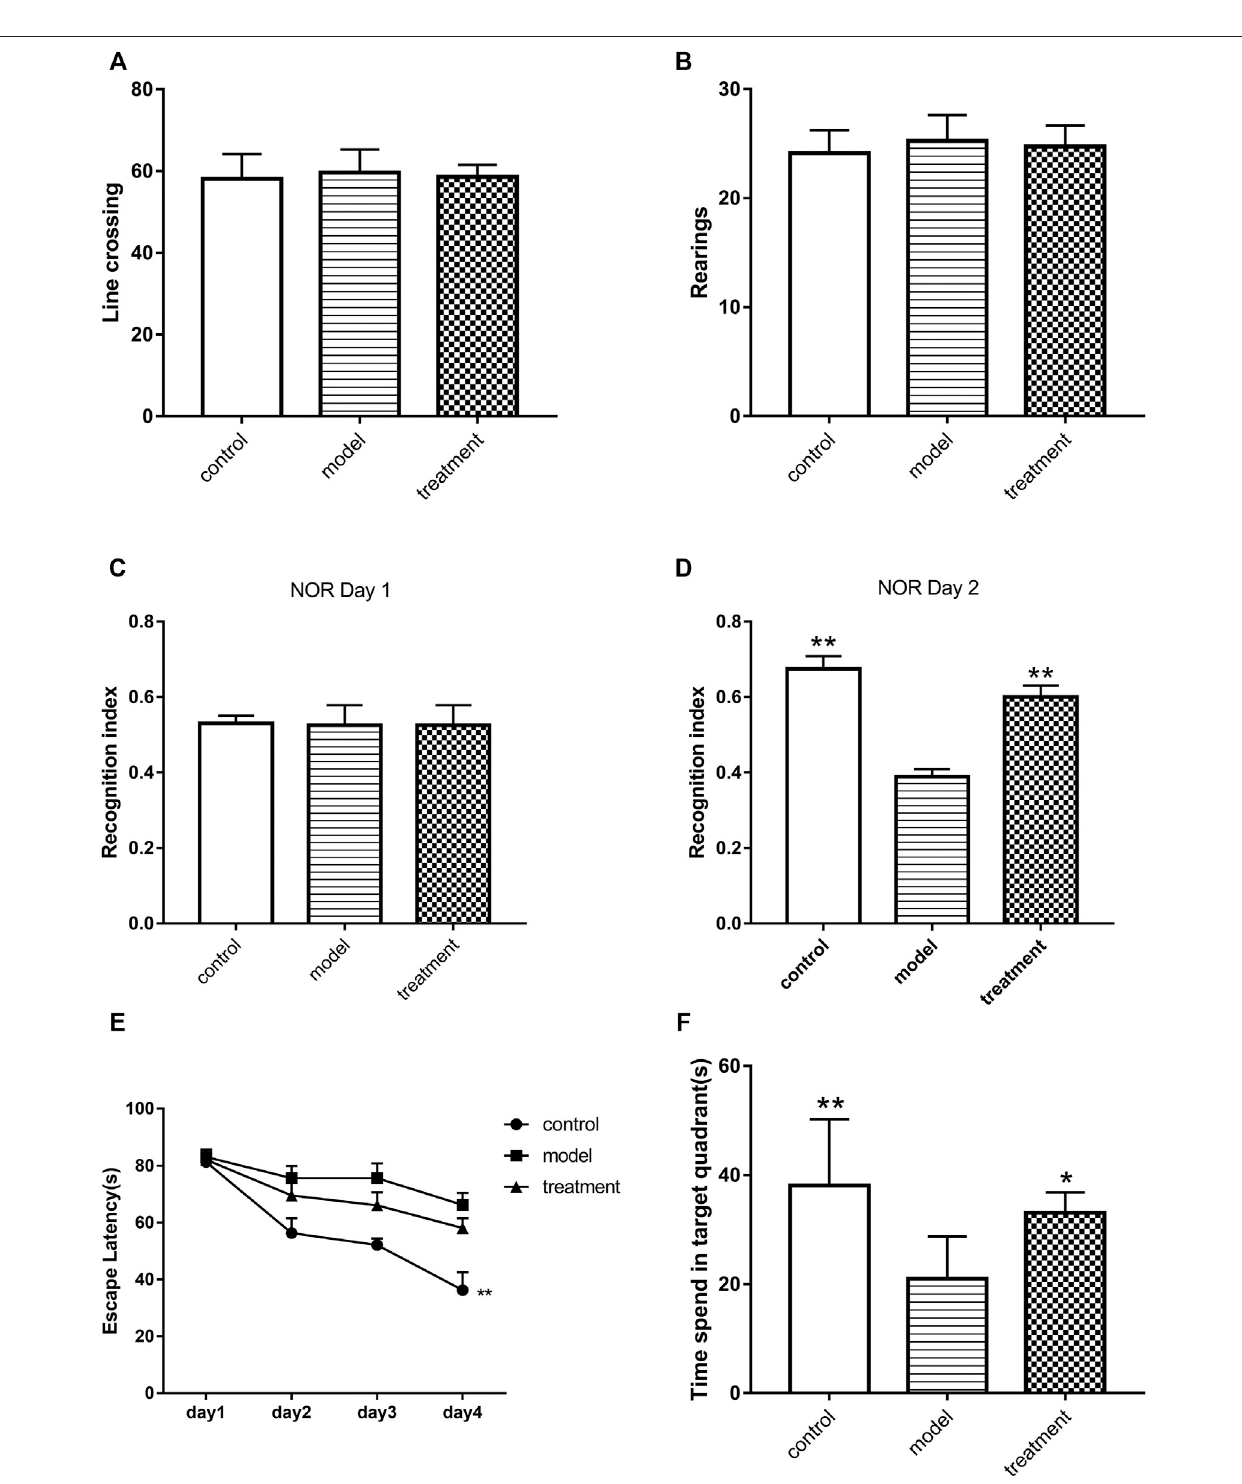
FIGURE2| Theresultsofanimalbehaviorexperiments. (A – B) Thetimesofmiceforcrossinglines (A) and rearing (B) intheOFT;inthe (C) 1stdayand (D) 2ndday ofNOR, therecognitionindexofmice fortwoidenticaland new objects; (E) during the4-day training period ofMWM, thetime ofeach groupofmice to fi ndtheplatform; (F) after the platform wasremoved onthe 5thday ofMWM,the time ofmice tospendin thetarget quadrant.Datarepresentthe mean± SEM( n =6); * p < 0.05 and ** p < 0.01 versus A β oligomer model group (one-way ANOVA and Dunnett- t test).